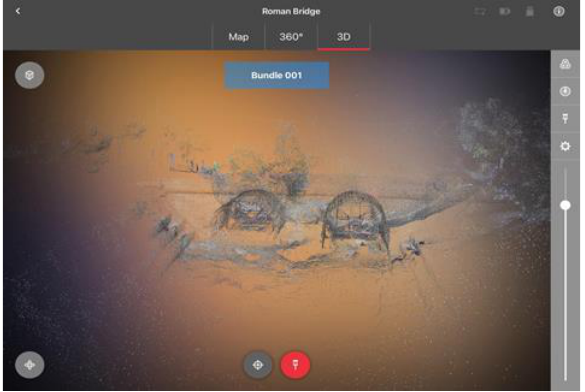
Figure 4 . In-situ pre-registration of the scans.